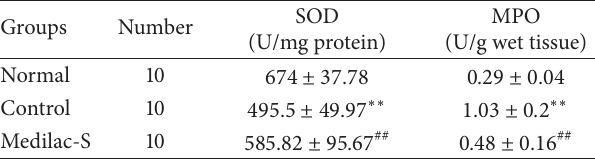
Table 2: The activities of SOD and MPO in groups.